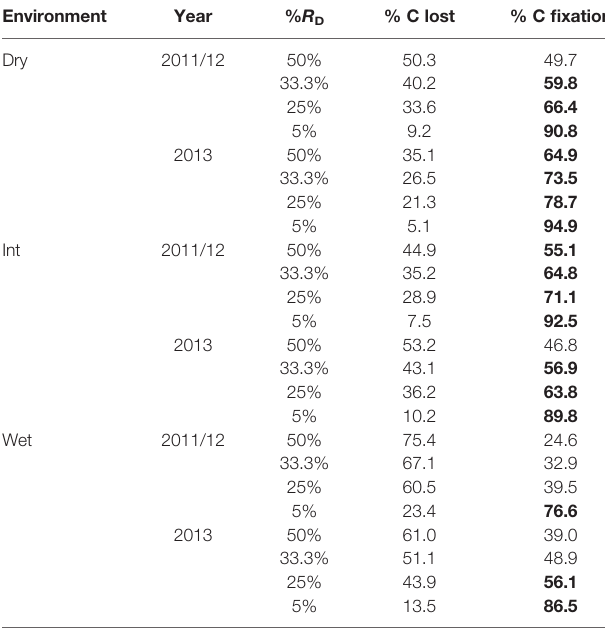
TABLE 4 | Estimated carbon balance for East Antarctic S. antarctici calculated from surface temperature data (see Environmental Moisture Effect on Moss Surface Temperature ) and temperature response of A sat (see Mesophyll Conductance and NPQ Measurement